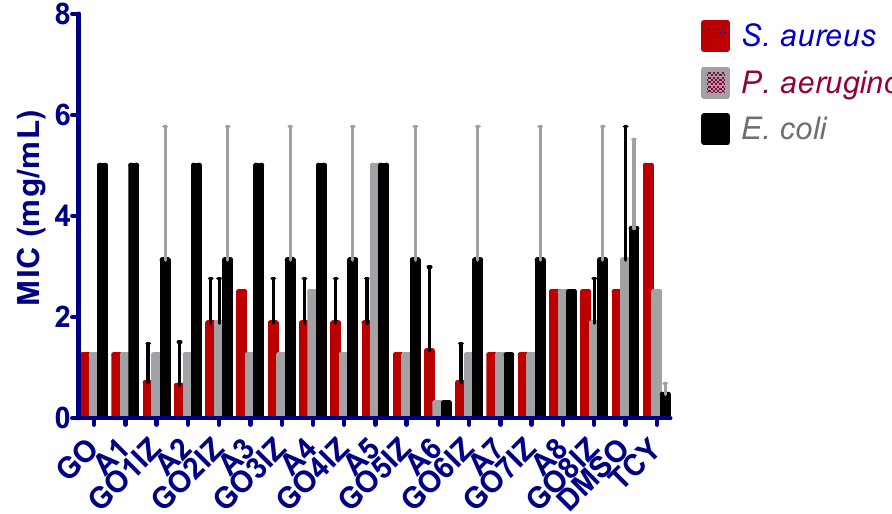
Figure 6. MIC values obtained for the synthesized compounds against the tested strains.